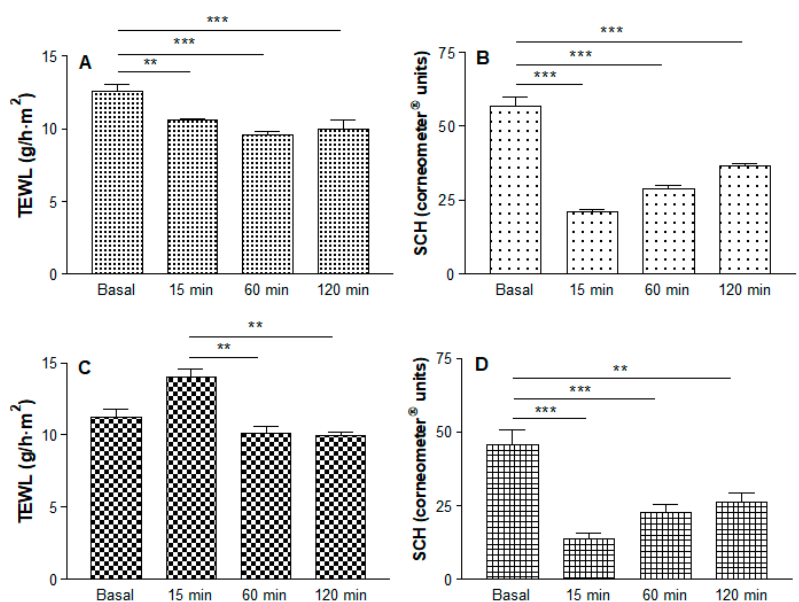
Figure 7. Measurements of biomechanical parameters of skin for 2 h after application of the gel and solution. ( A ) Change in trans-epidermal water loss (TEWL) and ( B ) Stratum corneum hydration (SCH) values after application of MA solution. ( C ) Change in TEWL and ( D ) SCH values after application of MA gel (** p < 0.01; *** p < 0.001).